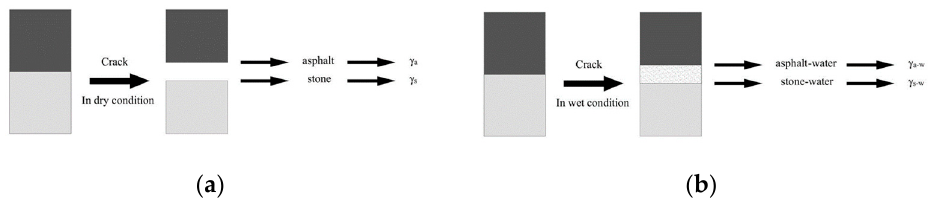
Figure 13. Schematic diagram of asphalt–aggregate adhesion-cracking model: ( a ) Dry condition; ( b ) Wet Condition.